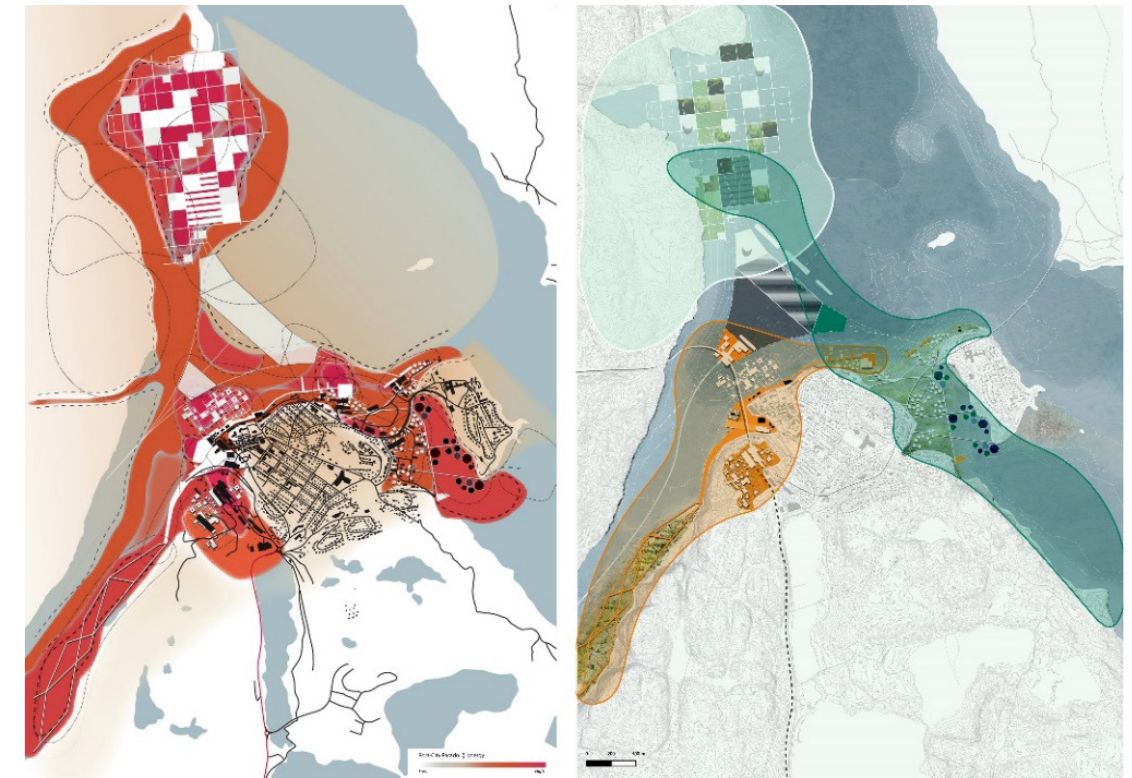
Figure 4. The synergistic interrelations between local specificities of the city and its surrounding and the port, resulting in a multiple set of spatial and temporal implementations and interventions. Source: Höller (2020).